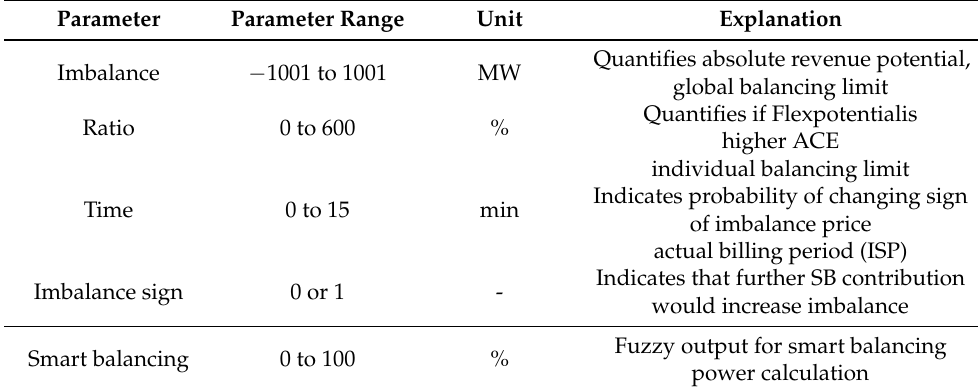
Quantifies if Flexpotentialis higher ACE individual balancing limit Indicates probability of changing sign of imbalance price actual billing period (ISP) Indicates that further SB contribution would increase imbalance Fuzzy output for smart balancing power